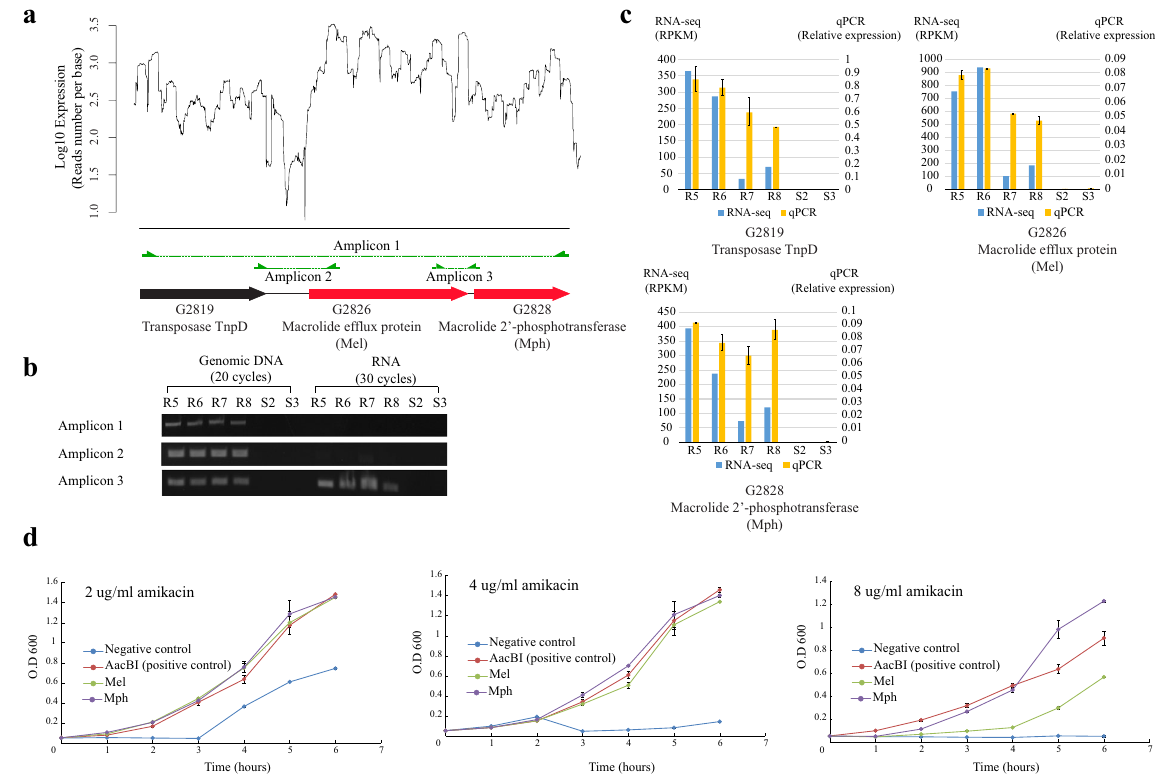
Figure 6. Transposon-associated mel and mph were co-transcribed and both contributed to amikacin resistance. ( a ) Transcript structure of the transposon gene with the two candidates. ( b ) Reverse-transcription PCR result of connection regions among three genes ( mel , mph , and tnpD ). ( c ) Quantitative PCR results for those three genes. ( d ) Growth of E . coli transformed with the two candidate genes ( mel and mph ) in different amikacin